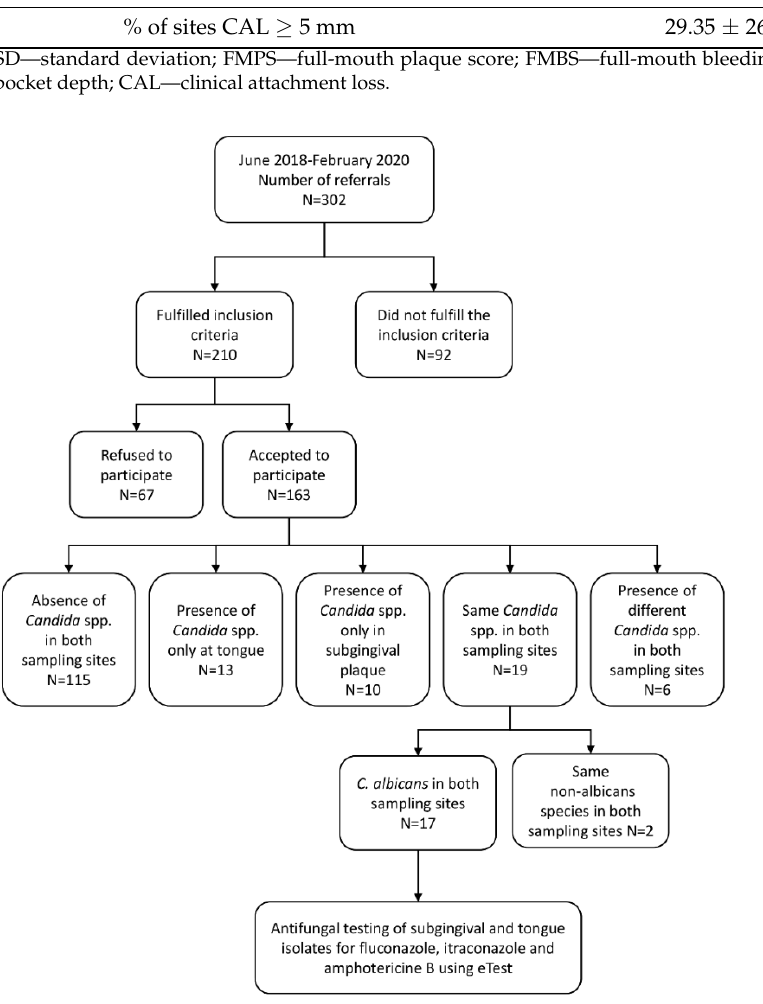
Figure 1. Flow chart of the study participants and study